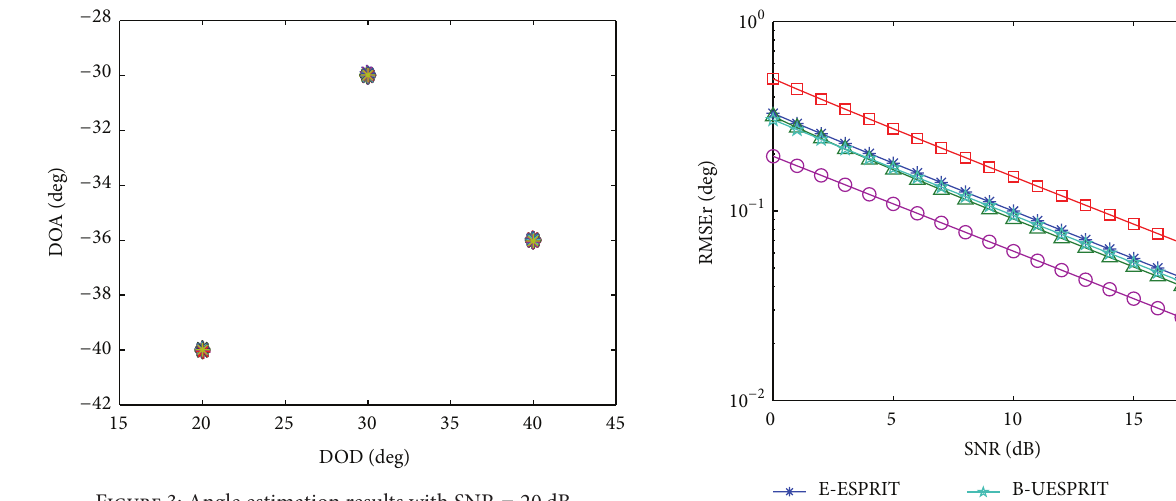
Figure 3: Angle estimation results with SNR = 20 dB.